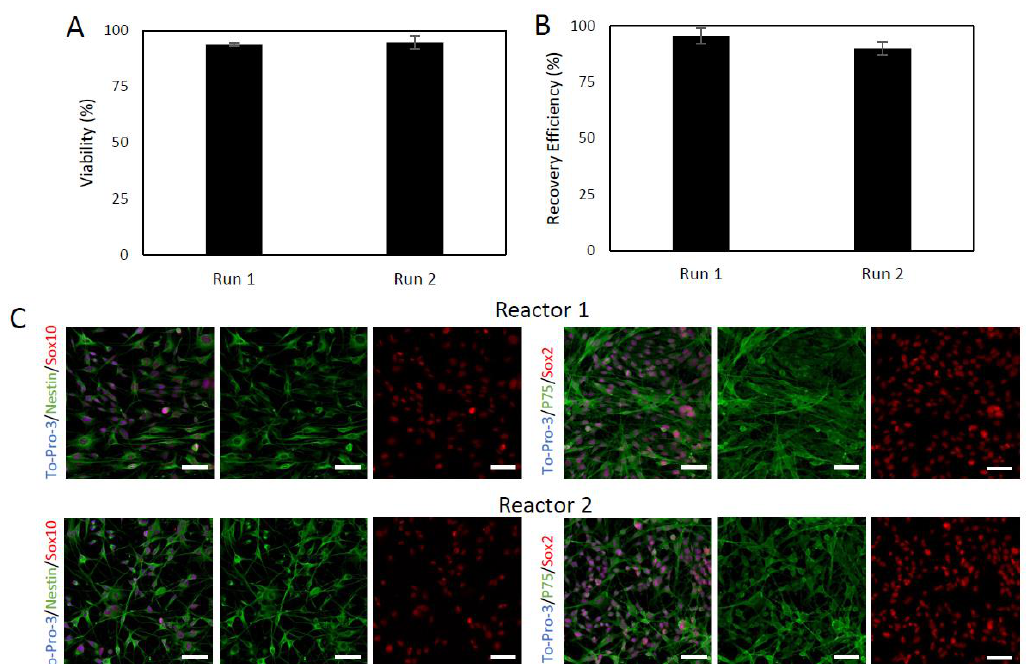
Figure 6. Viability and recovery efficiency following post-harvest cryopreservation of Sk-SCs expanded in 500 mL DASGIP bioreactors. Harvested Sk-SC were cryopreserved and stored in liquid nitrogen for 7 days to represent the shipping and storage requirements of a cell therapy. The cells were thawed and assessed for viability ( A ) and recovery efficiency ( B ). ( C ) Immunophenotype of post-expansion cryopreserved Sk-SCs. The post-expansion Sk-SCs were stained for expression of characteristic markers Sox10, Sox2, P75, and nestin. Scale bars represent 200 µ m. Error bars represent one standard deviation of the mean.